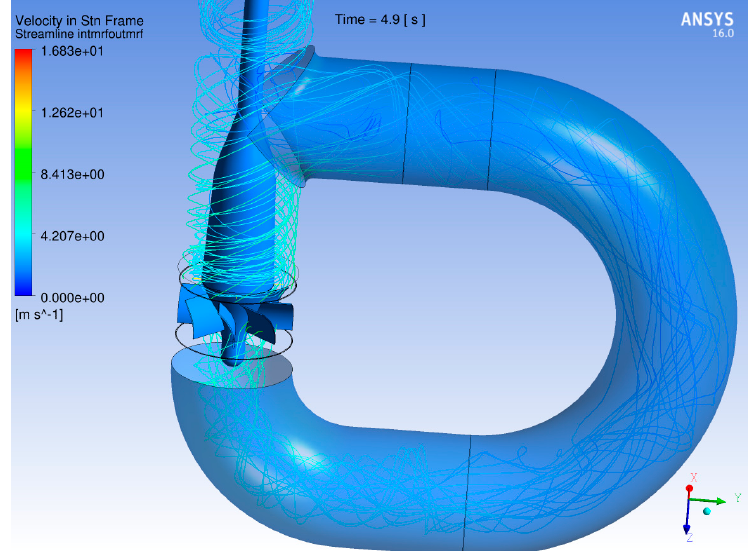
Figure 20. Pathlines inside the virtual loop (the high flow swirl at the SG inlet is visible).